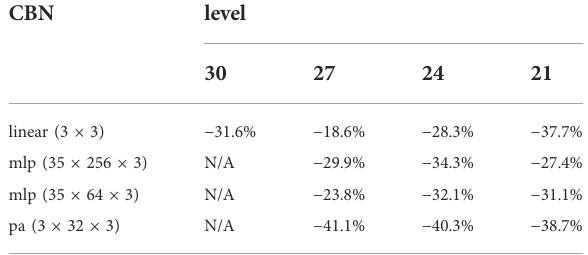
TABLE 1 BD-Rate reductions due to normalization, averaged over point clouds. Normalization is crucial for good performance. Without normalization, there is no dependence on